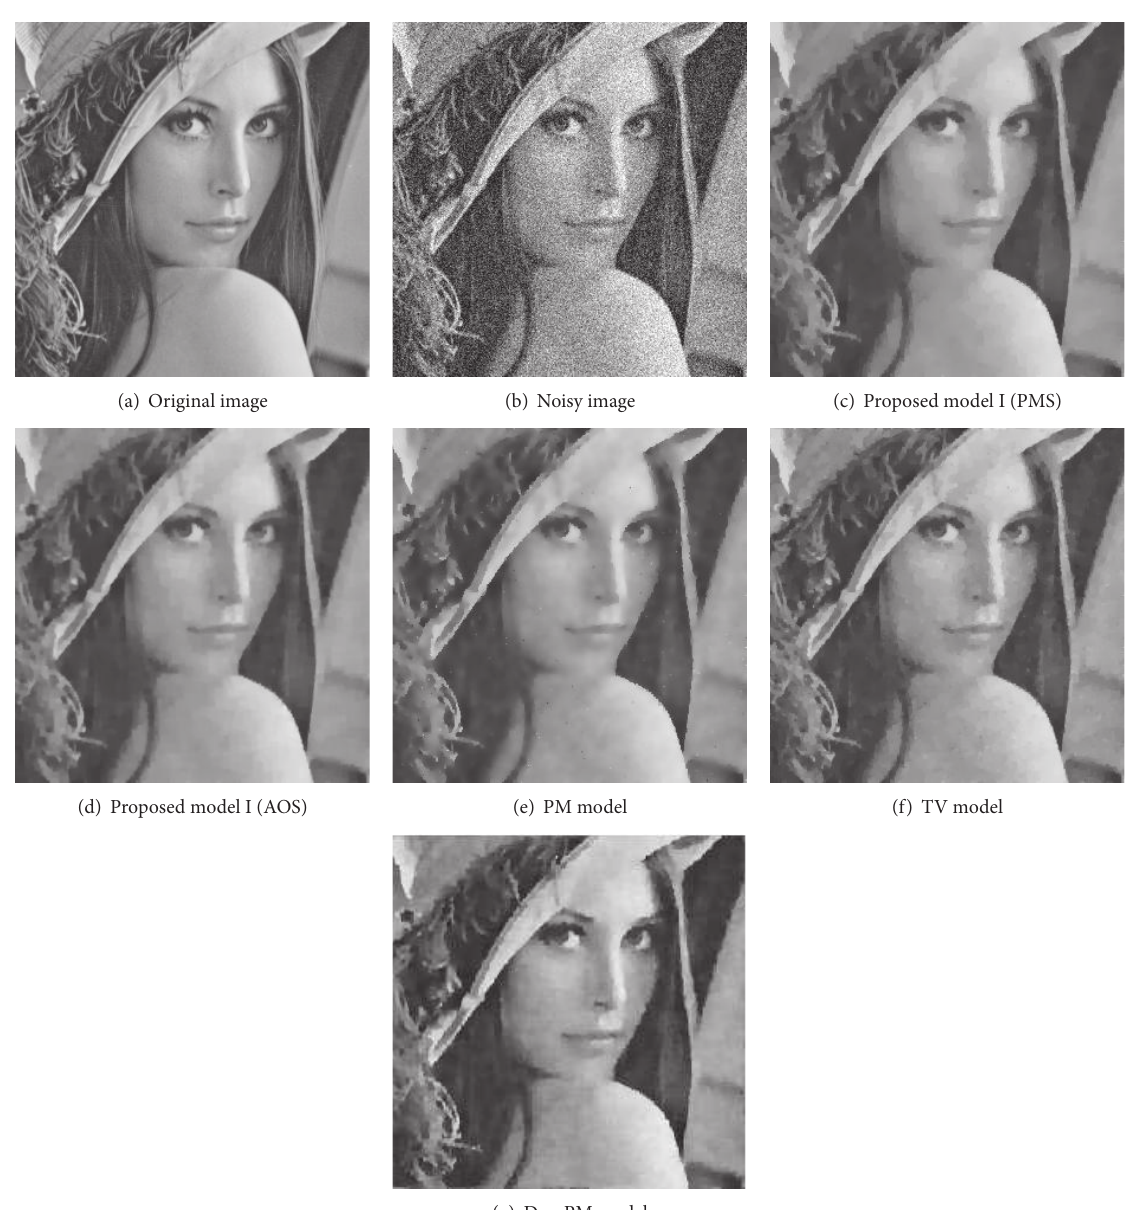
Figure 3: Lena image ( 300 × 300 ). (a) Original image. (b) Noisy image corrupted by Gaussian noise for 𝜎 = 30 . (c) Our algorithm by PMS; 𝜏 = 0.2 (122 steps). (d) Our algorithm by AOS scheme; 𝜏 = 2 (7 steps). (e) PM method; 𝐾 = 12 and 𝜏 = 0.25 (60 steps). (f) TV method; = 0.5 , 𝜎 = 30 , 𝜏 = 2 , and 𝐾 = 4 (13 𝜏 = 0.2 (149 steps). (g) D- 𝛼 -PM method; 𝜎 1